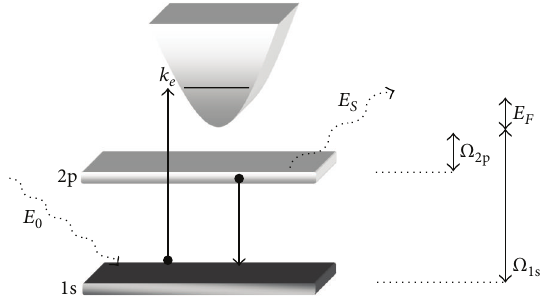
Figure 1: Schematic representation of a 2p → 1s X-ray resonant Raman scattering